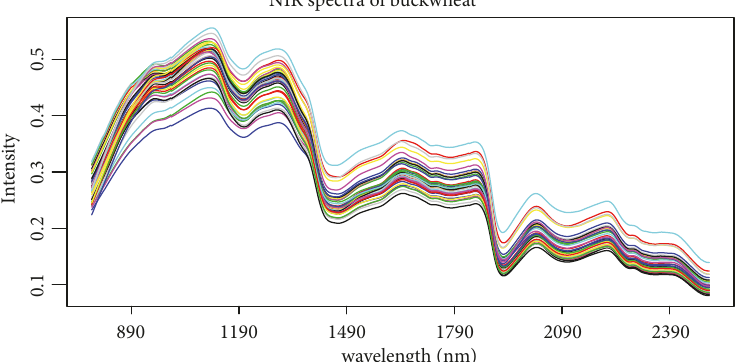
Figure 9: The intensity of each wavelength (predictors) from buckwheat data